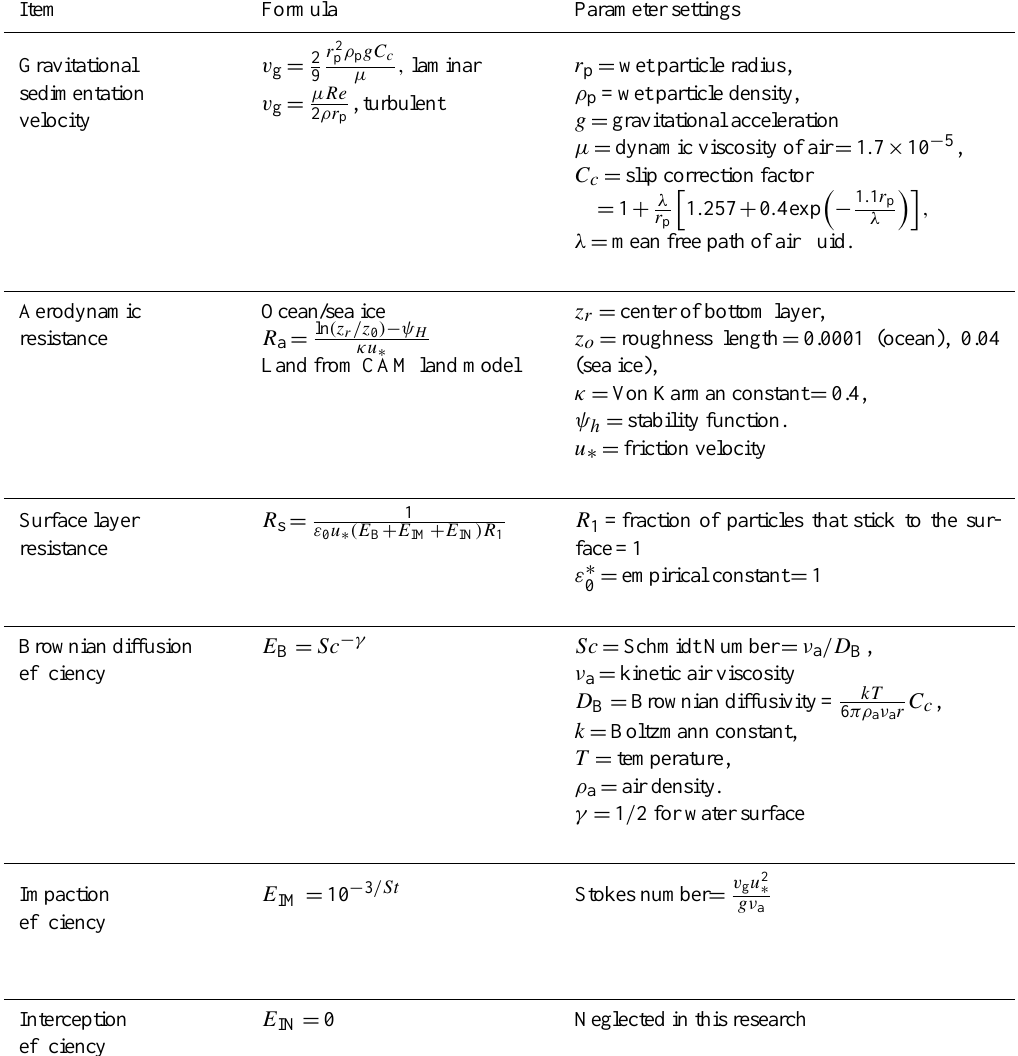
Table 2. Dry deposition